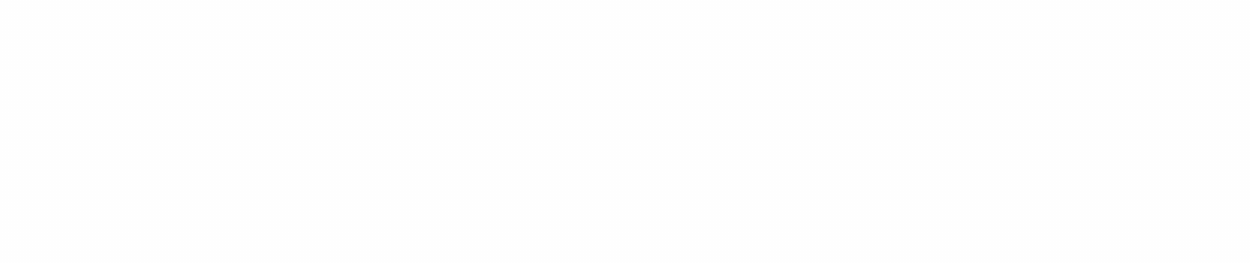
FIGURE 3 Absence of the early activation marker ICAM1 from CD4+/CD3 T cells derived from an MG-associated cortical thymoma. For comparison, an increased number of activated T cells is detectable in thymoytes from thymitis as compared to the normal thymus. The histogram shown is representative for three other cortical thymomas and three mixed thymomas investigated in the same way by flow cytometry. A similar finding was obtained with an antibody to the late activation antigen CD25 (not